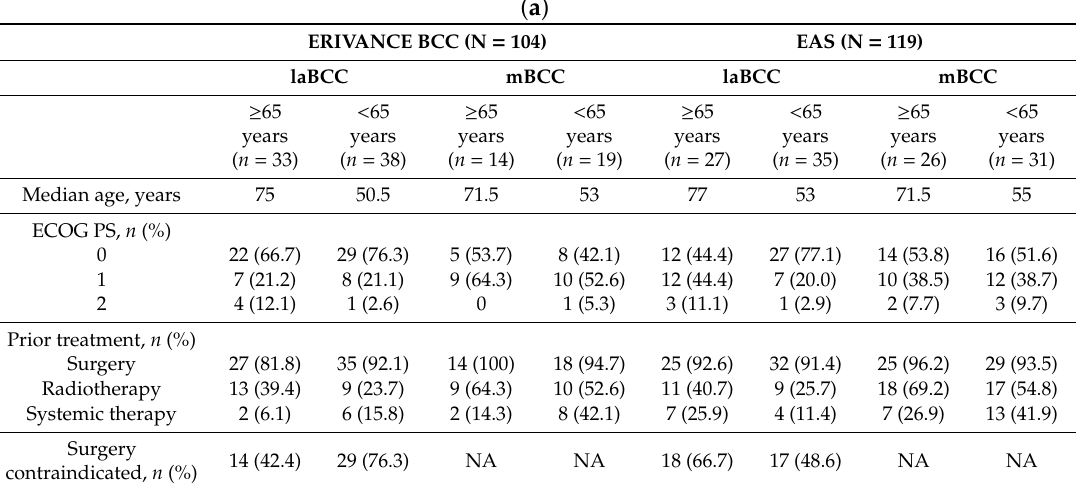
Table 3. ( a ) Baseline patient and diseases characteristics. ( b ) E ffi cacy of Vismodegib in elderly BCC